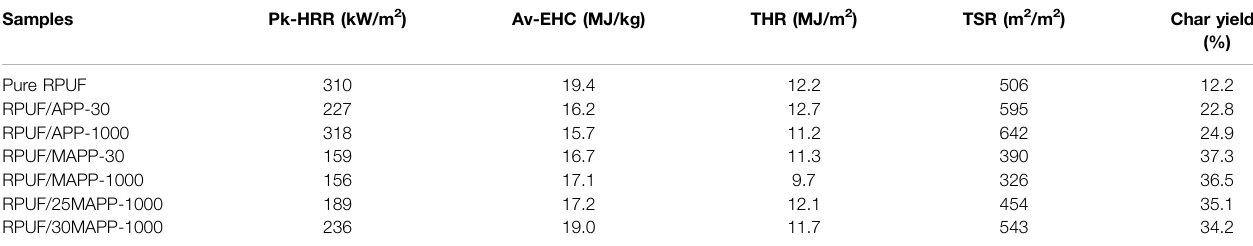
TABLE 4 | Results of cone calorimeter test for RPUF composites. Samples